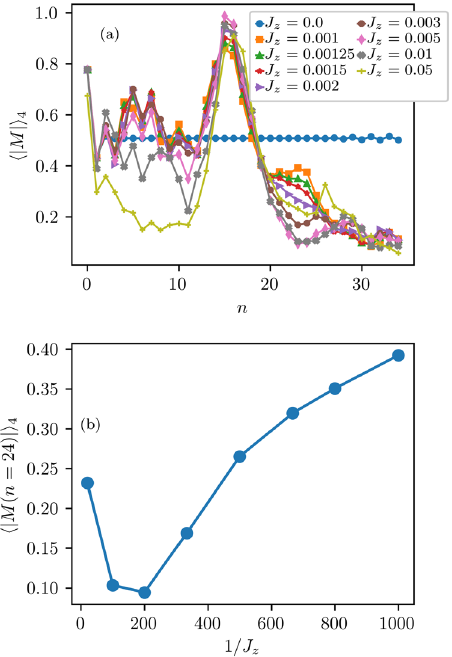
Fig. 6 Interaction dependence of the dimerization of the Krylov chain. The plot of the absolute value of the difference between neighboring Krylov hopping parameters b n s, M ( n ) = b n + 1 − b n , after a moving average over four sites, and denoted as 〈 ∣ M ∣ 〉 4 , where n labels the sites of the Krylov chain. Panel a shows how this quantity varies with n and interaction J z . Panel b shows the variation with 1/ J z for this quantity at n = 24. This site is chosen because the interaction effects are the strongest here. Panel b indicates that the dimerization decays with interactions as 〈 ∣ M ( n = 24) ∣ 〉 4 ∝ 1/ J z for 1/ J z ≫